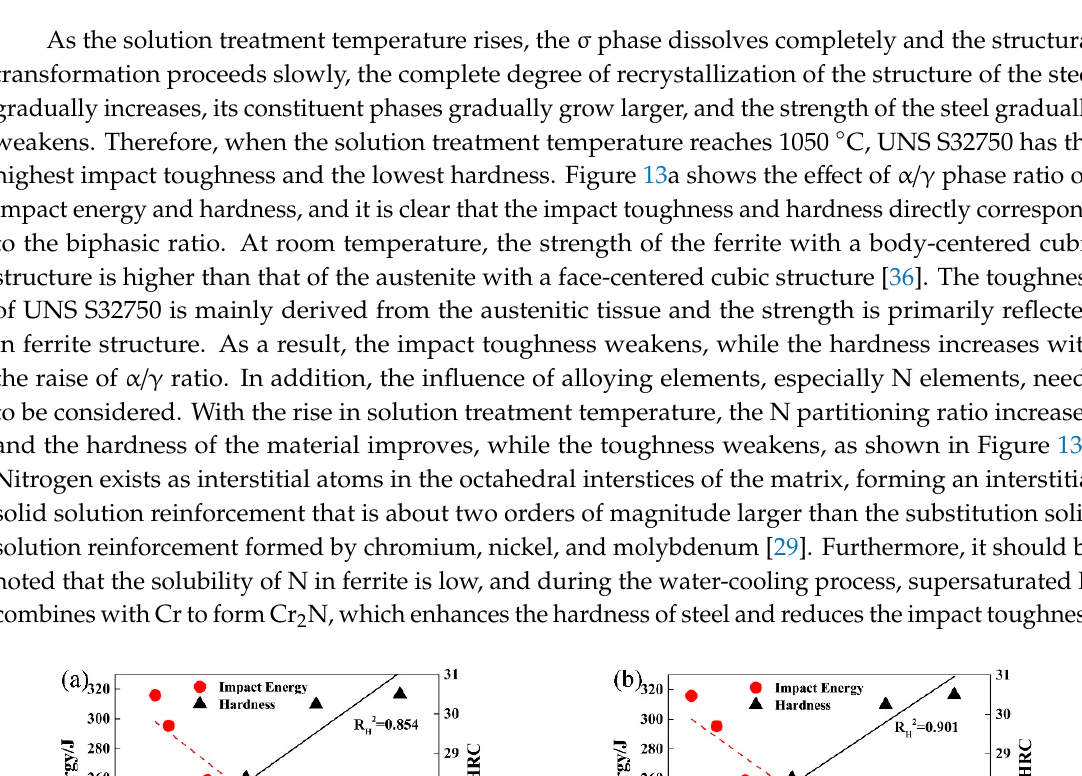
Figure 12. Effect of σ phase on impact energy and hardness.